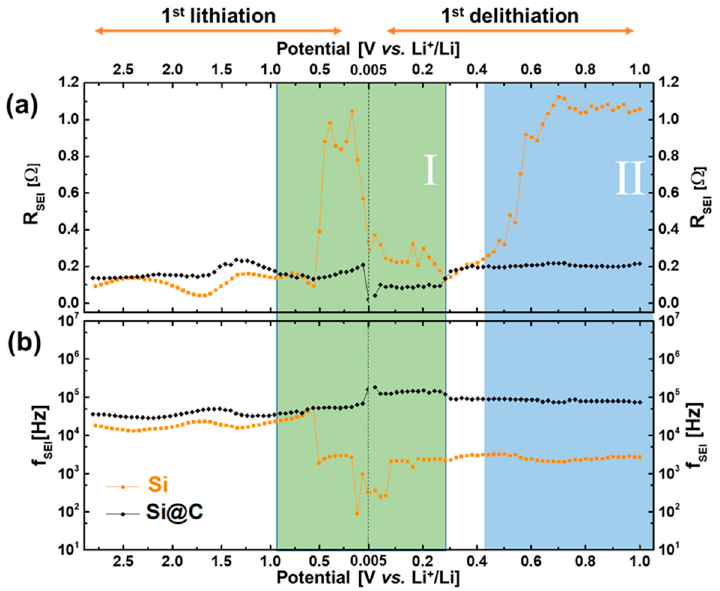
Figure 5. ( a ) Resistances and ( b ) frequencies of the SEI for both Si (orange) and Si@C (black) materials. Two distinct zones exhibit different behaviors of resistances and/or frequencies.